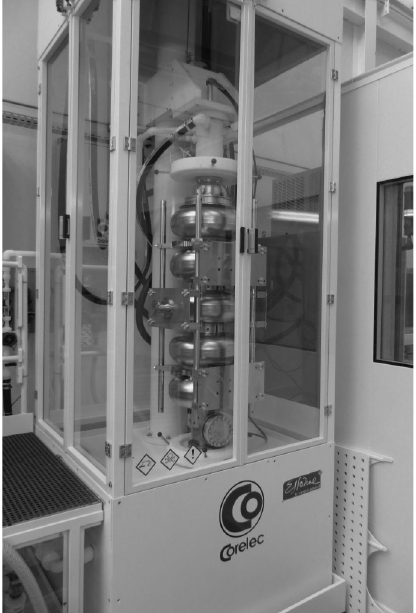
FIG. 1. Five-cell SPL cavity during VEP